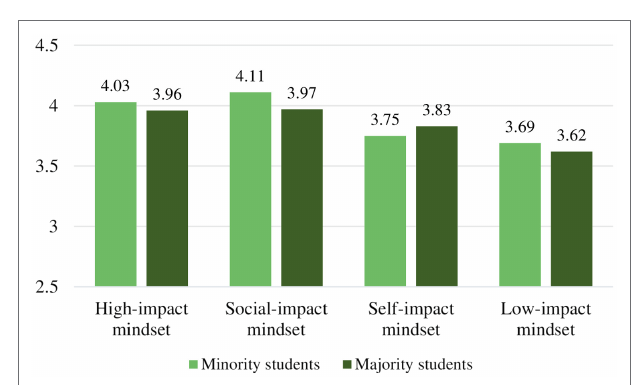
FIGURE 4 | Ethnic group mean levels in sense of